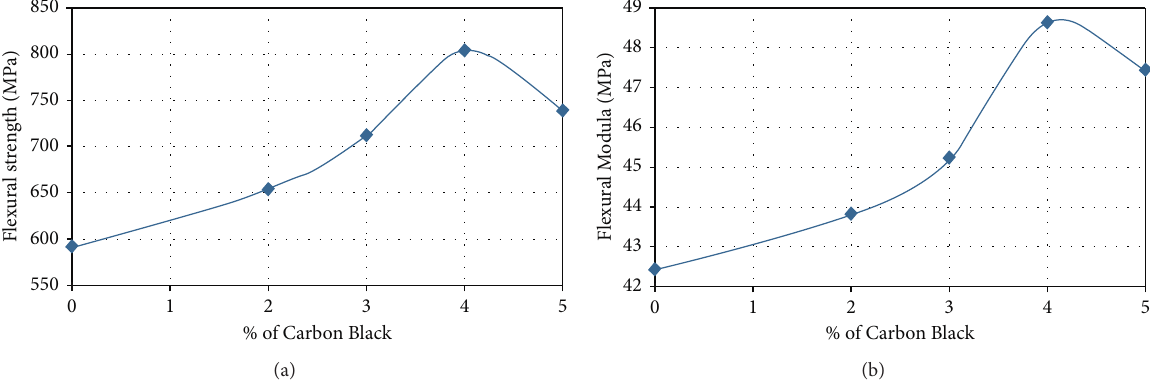
Figure 6: (a) Effect of carbon black on flexural strength of the vinyl ester composites. (b) Effect of carbon black on flexural modulus of the vinyl ester